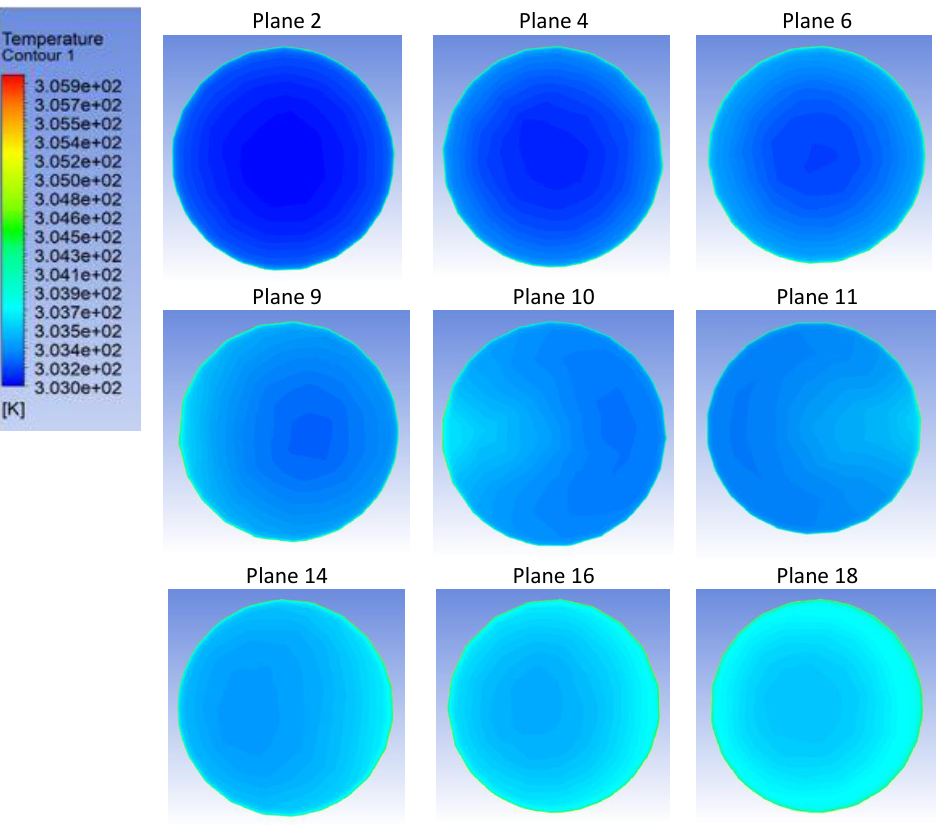
Figure 8. Temperature contour distribution at each plane location using water at Grid